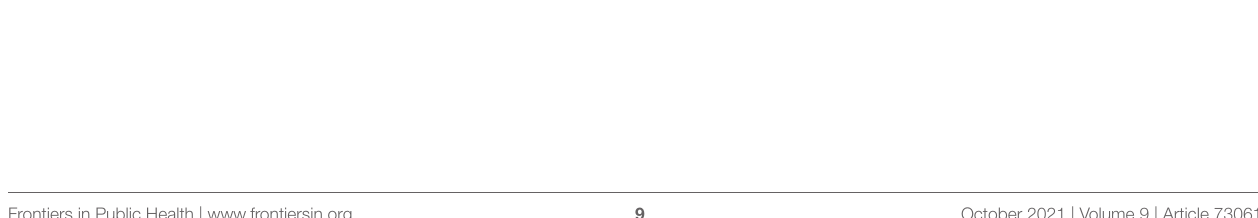
Frontiers in Public Health |